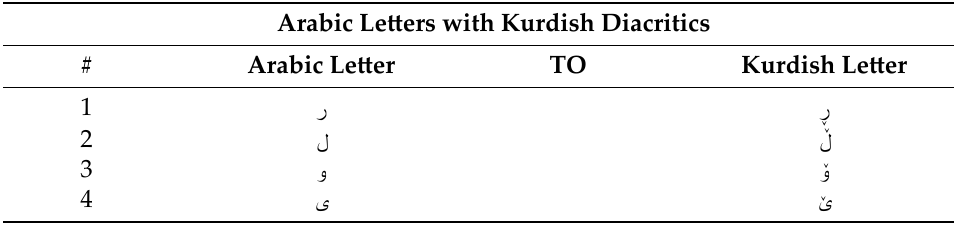
Table 5. Diacritics added to the Arabic letters to create Kurdish letters.